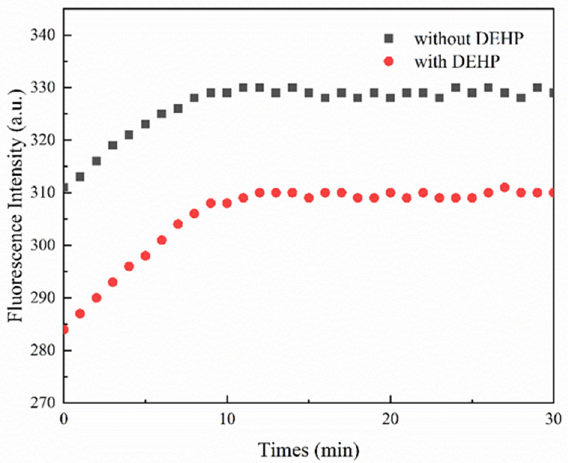
Figure 1. Fluorescence signal variables of feasibility analysis. Under the condition of adding 20 µg/L DEHP, the change value of the fluorescence signal was determined. The change in the fluorescence signal without DEHP was used as a negative control.